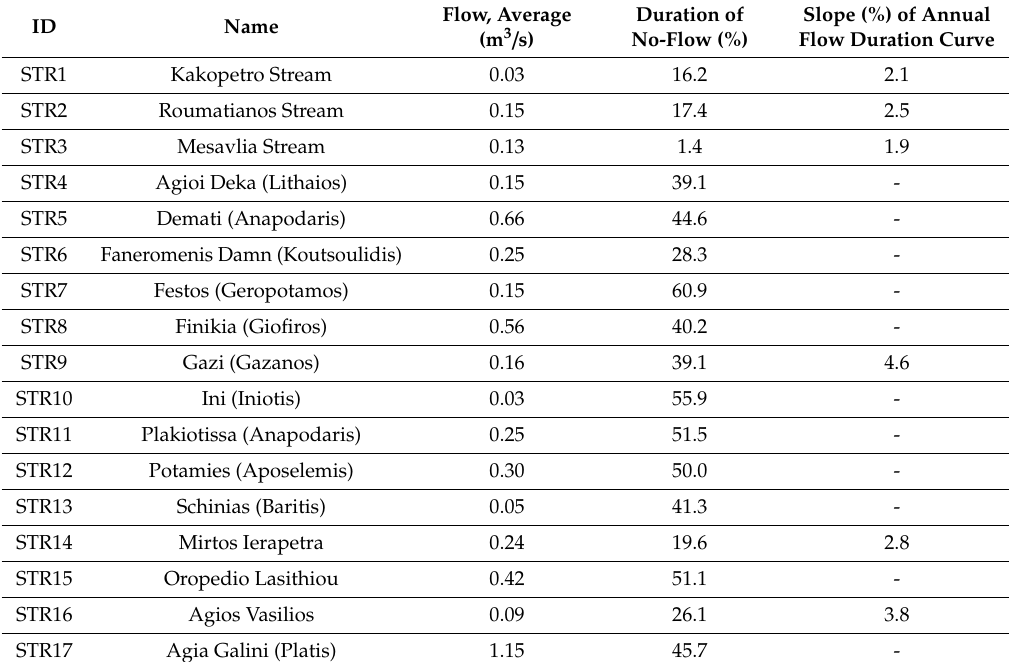
Figure 6. Flow duration curve for the 50-year period of 1956–2005. Table 2. Intermittent rivers of Crete with acronyms and duration of